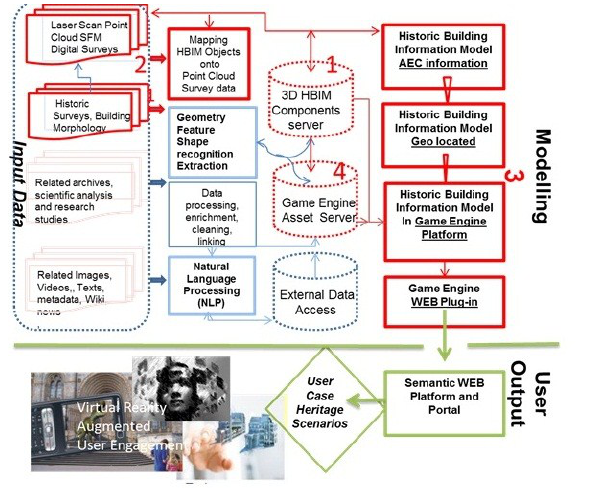
Figure 15: Architecture for HBIM to Game Engine Semantic WEB is employed to extract information and to relate digital content. The semantically enriched model can